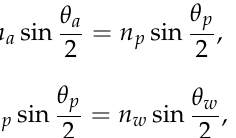
Figure 3. The applied setup: 1—intercrossing laser beams, 2—flow explorer with optics system, 3—optical fiber, 4—signal wire to photo-multiplier, 5—The Burst Spectrum Analyzer, 6—the stepper motor controller, 7—x,y,z movement signal wires, 8—the elements of linear stroke along x,y,z axis with spindle drives, 9—personal computer, 10—pump, 11—discharge pipe, 12—upper tank, 13—inlet pipe, 14—straight pipe coupler, 15—transparent tube, 16—valve, 17—temperature meter, 18—outlet pipe, 19—needle valve, 20—float meter, 21—bottom tank, 22—overflow pipe.